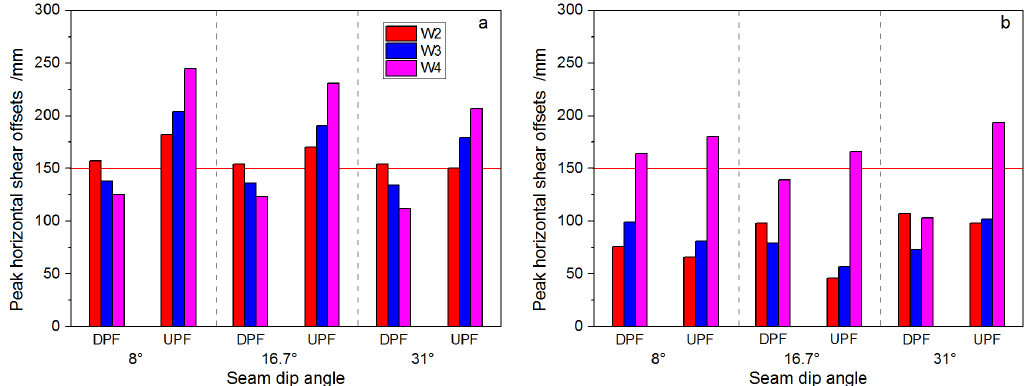
Figure 12. Peak horizontal shear offsets of well trajectories W2–W4 for longwall mining along strike after only one panel ( a ) and then both panels are removed ( b ) in cases of different extraction sequence. “DPF” represents the downdip panel is removed first and then the updip panel. “UPF” represents the updip panel is removed first and then the downdip